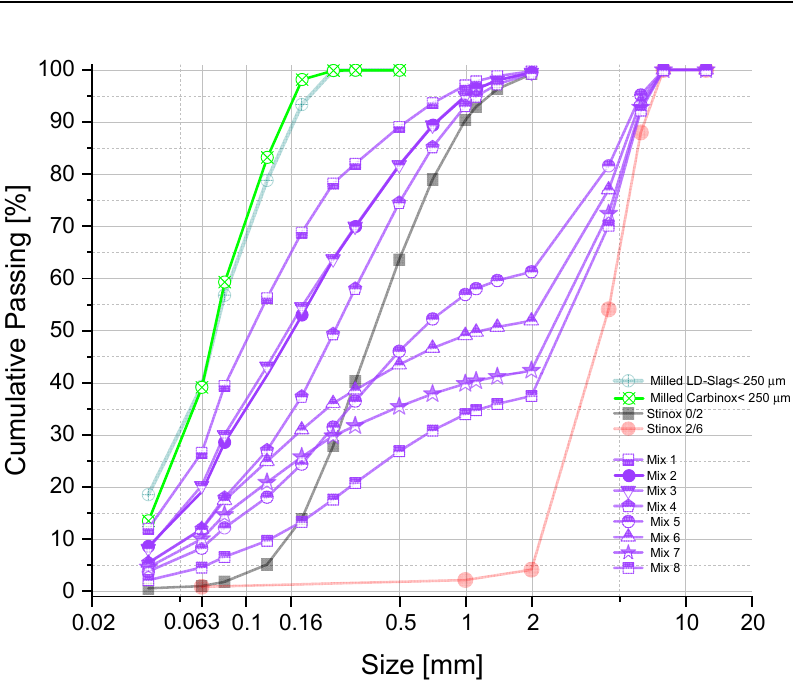
Figure 2. Overall cumulative particle size distribution of mixtures 1 to 8, along with cumulative particle size distribution of the components used in designing of the mixtures.